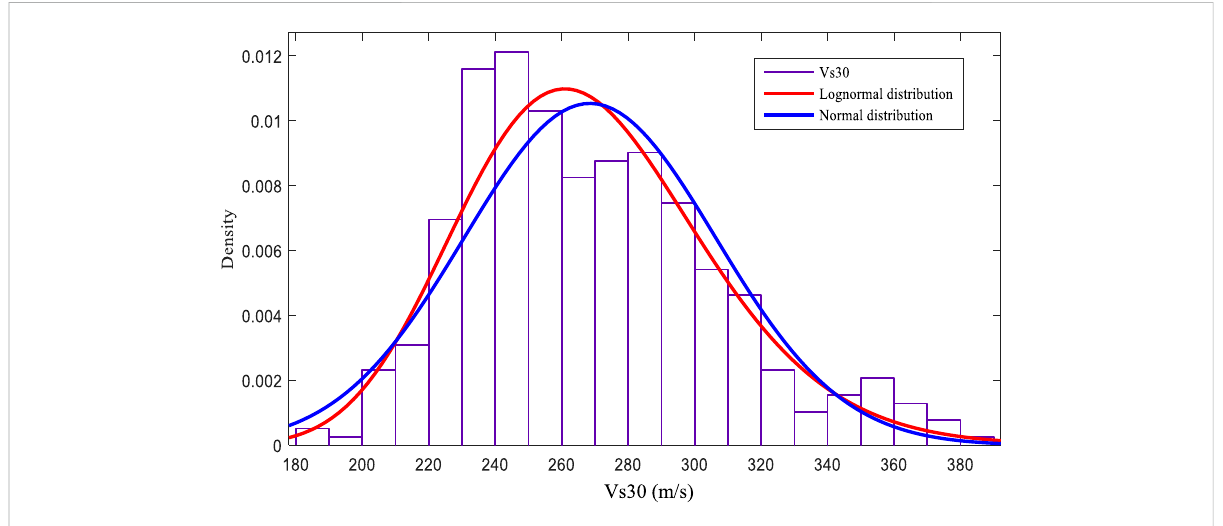
FIGURE 4 Histogram of selected 388 V s30 values calculated from shear wave velocity measurements.